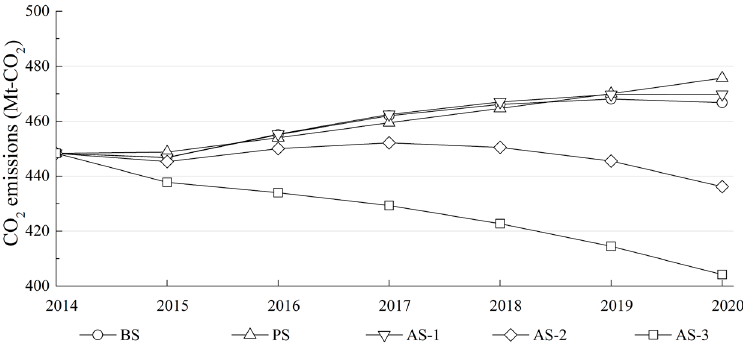
Figure 11. Household CO 2 emissions scenario simulation.